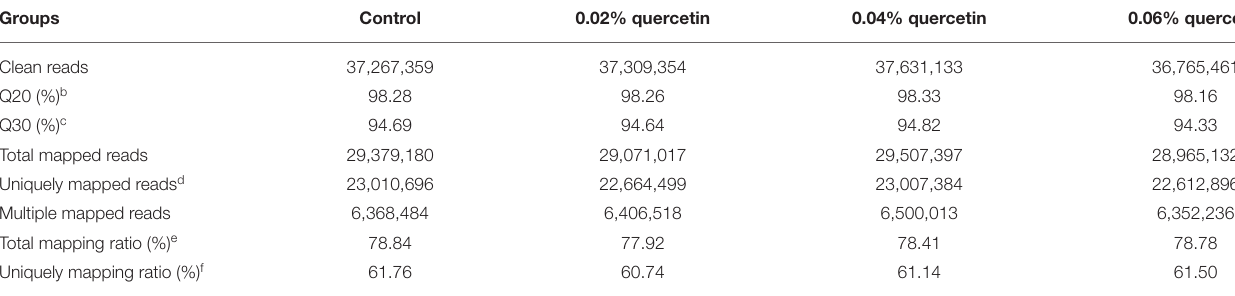
TABLE 6 | Summary statistics for sequence quality and alignment information of 12 samples from duodenal mucosa a . Groups Control 0.02% quercetin 0.04% quercetin 0.06% quercetin